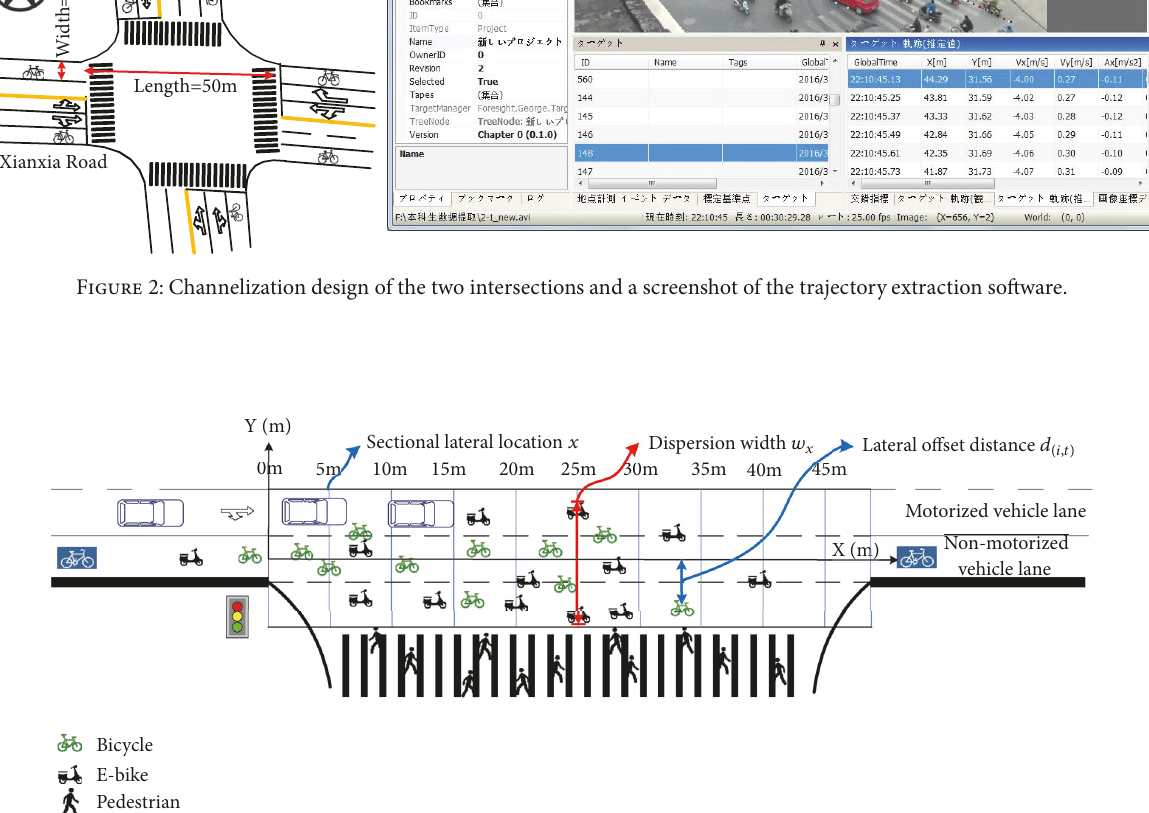
Figure 3: Illustration of the sectional lateral location, the dispersion width and the lateral offset